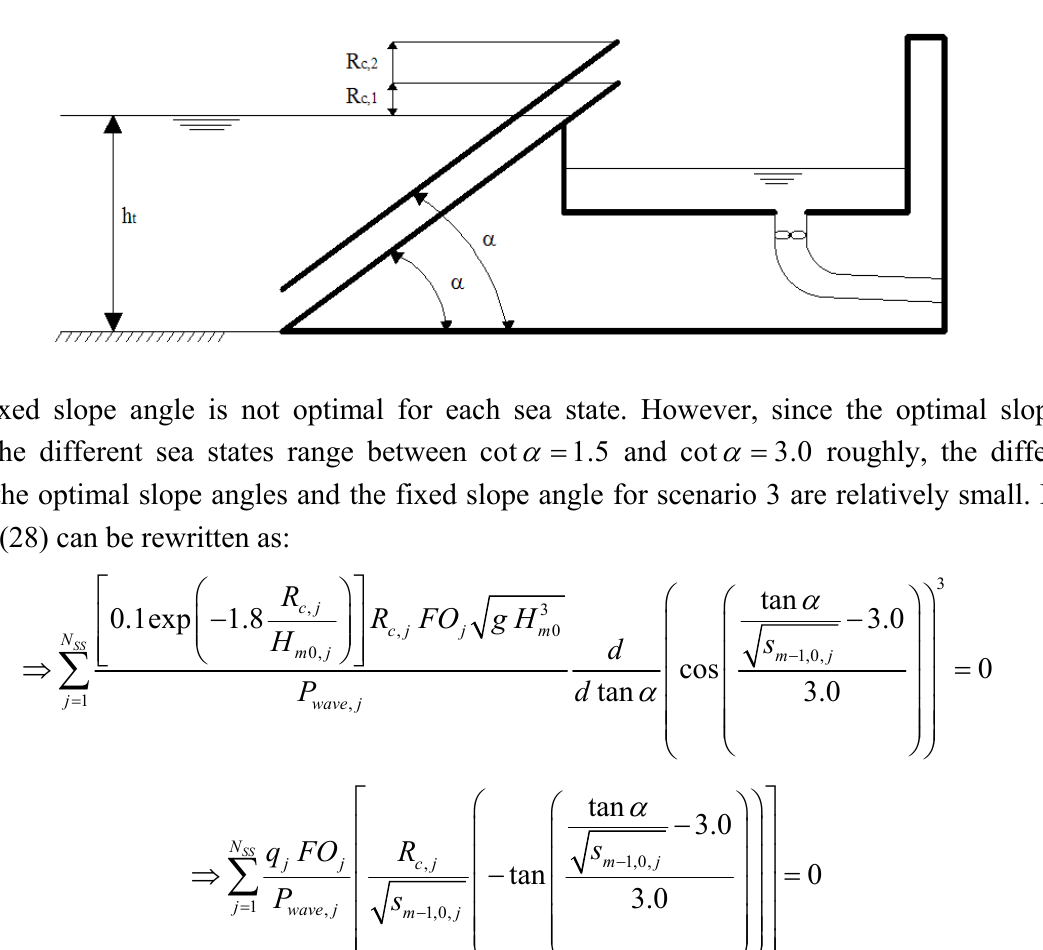
Figure 5. Scenario 3—Geometry control by adaptive crest freeboard